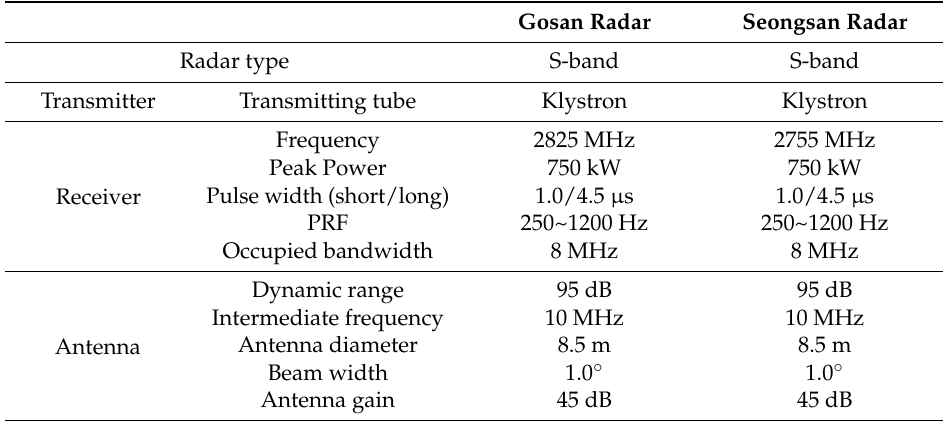
Table 1. Major specification of the Gosan and Seongsan Radars.